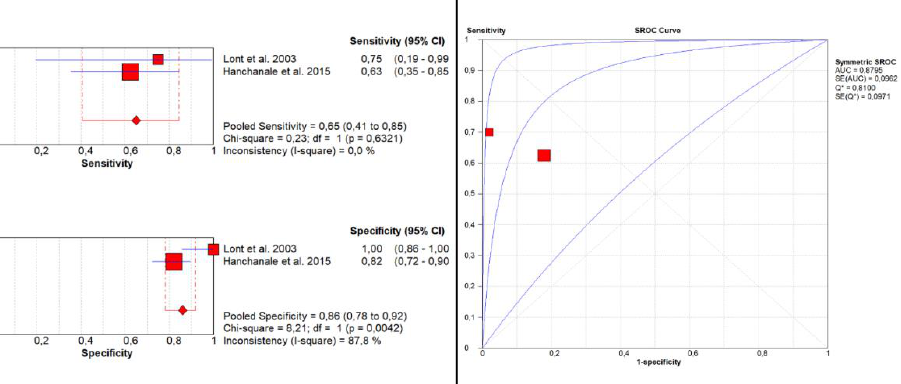
Figure 3. Pooled sensitivity, specificity, and SROC curve of MRI in detecting urethral invasion.